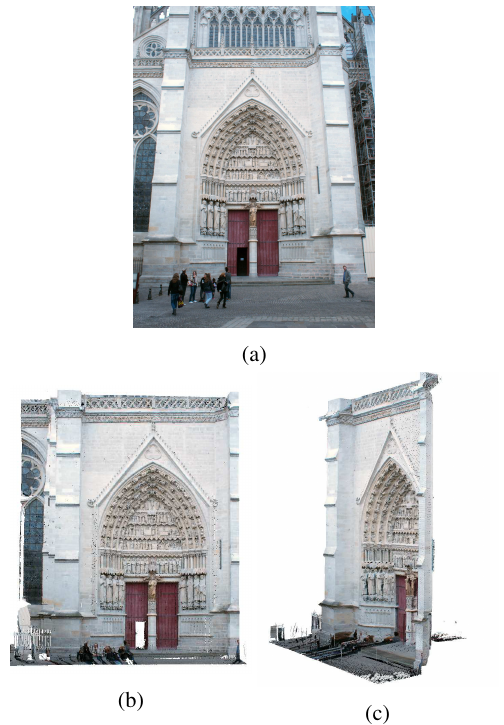
Figure 6: Colorization of the south portal : (a) desired digital image, (b-c) colorized point cloud, (e) evolution of the residual error during the servoing